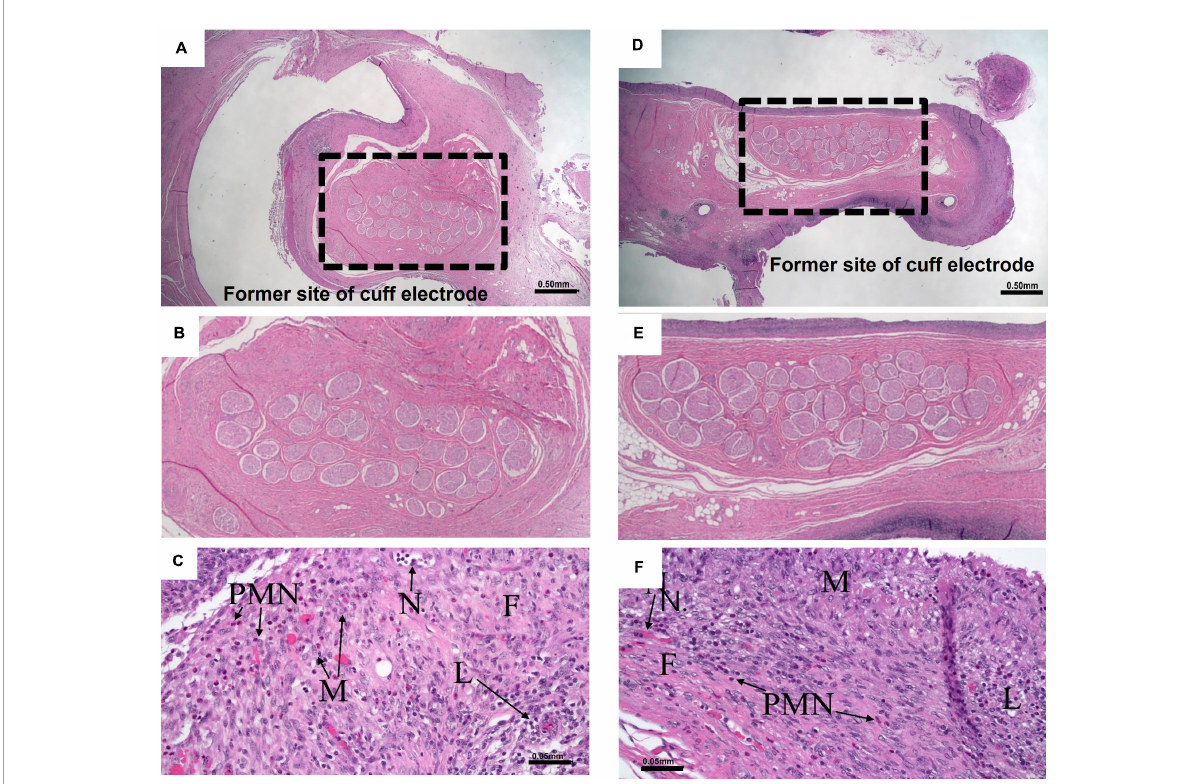
FIGURE11 Nerves and surrounding tissue were healthy after 5 of high frequency alternating current (HFAC) + stimulation applications. (A) A 10 × view of the Vagus nerve surrounded by space formally occupied by electrode delivering HFAC. Scale bar 0.5 mm (B) Expanded view of nerve facials taken from the dashed box in panel (A) . (C) Normal nerve surrounded by a minimally thick fibrous capsule with moderate fibroblasts and 5–10 vascular profiles present per field of view at 200 × total magnification that were fine new blood vessels. There was minimal subacute hemorrhage in the capsule and mild amounts of necrosis along the margin of the capsule. Moderate numbers of lymphocytes and macrophages and mild numbers of polymorphonuclear cells infiltrated the capsule. Scale bar 0.05 mm. Abbreviations: F, fibrous capsule; N, neovascularization; L, lymphocytes; PMN, polymorphonuclear cells; M, macrophages. (D) A 10 × view of the Vagus nerve surrounded by space formally occupied by electrode delivering stimulation. Scale bar 0.5 mm. (E) Expanded view of nerve facials taken from the dashed box in panel (D) . (F) The slide consisted of normal nerve surrounded by a minimally thick fibrous capsule with mild fibroblasts and 5–10 vascular profiles present per field view at 200 × total magnification that were fine new blood vessels. There was mild subacute hemorrhage in the capsule. Minimal numbers of polymorphonuclear cells, moderate numbers of lymphocytes, moderate numbers of macrophages, and minimal numbers of multinucleated giant cells infiltrated the capsule. Scale bar 0.05 mm. Letters correspond to the exact abbreviations as in panel (C)